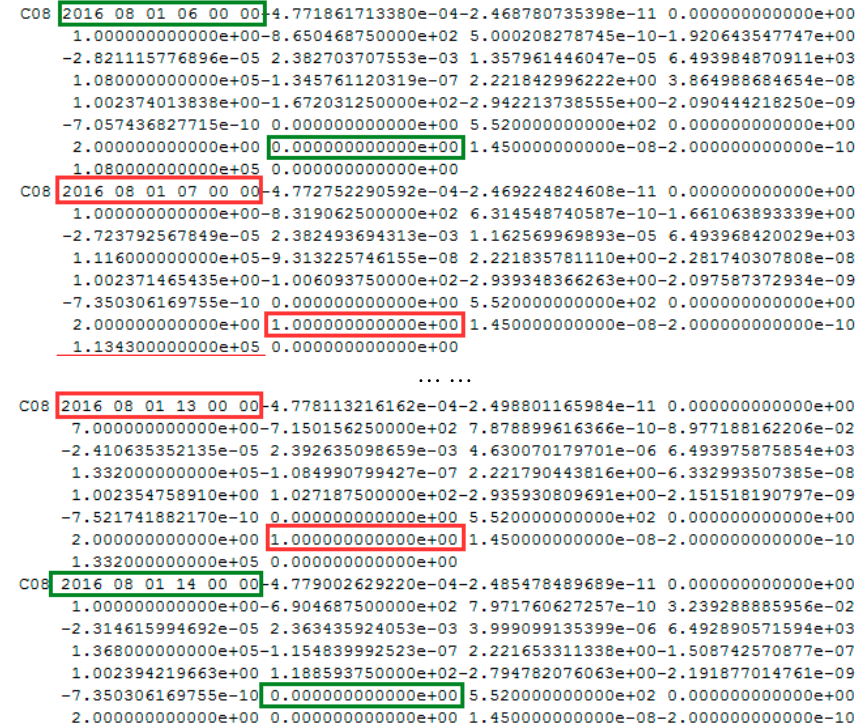
Figure 10. The health marks of C08 in the broadcast ephemeris. The red box highlights are the unhealthy status marked 1. The blue box highlights are the healthy status marked 0. Note the data from between 08:00 and 12:00 is not displayed to limit the size of the figure, and the healthy status are all marked 1 during this period.